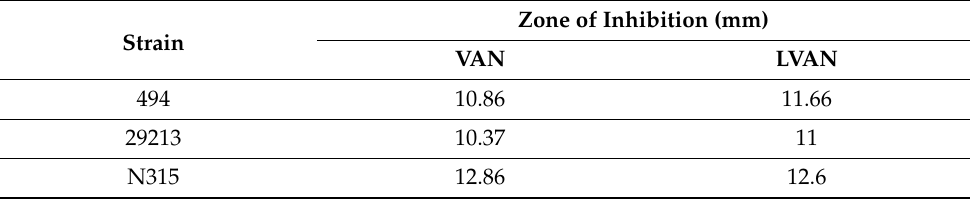
Table 2. Zone of inhibition (in mm) for different strains of MRSA and